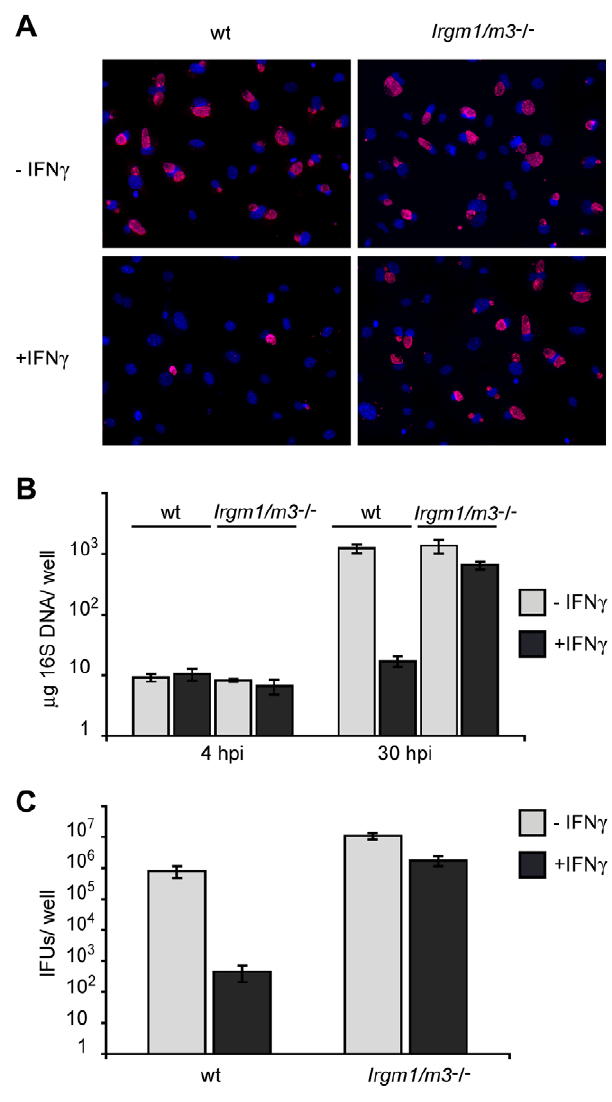
Figure 4. Cells doubly deficient for Irgm1 and Irgm3 exert minimal IFN c -induced cell-autonomous resistance to C.tracho- matis . IFN c -stimulated and unstimulated MEFs derived from wildtype B6 or Irgm1/m3 (-/-) mice were infected with C. trachomatis at an MOI of 2. (A) Cell nuclei were stained with DAPI and C. trachomatis inclusions were labeled using an anti-Hsp70 antibody (B) Bacterial growth was quantified using qPCR at 4 and 30 hpi and (C) using an inclusion- forming unit (IFU) assay at 48 hpi. Data is representative of at least two independent experiments.